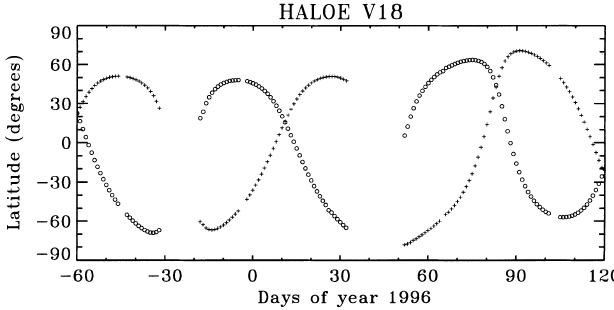
Fig. 1. Latitude coverage of HALOE observations from November 1, 1995 to April 30, 1996. Circles indicate sunrise observations, plus signs sunset observations